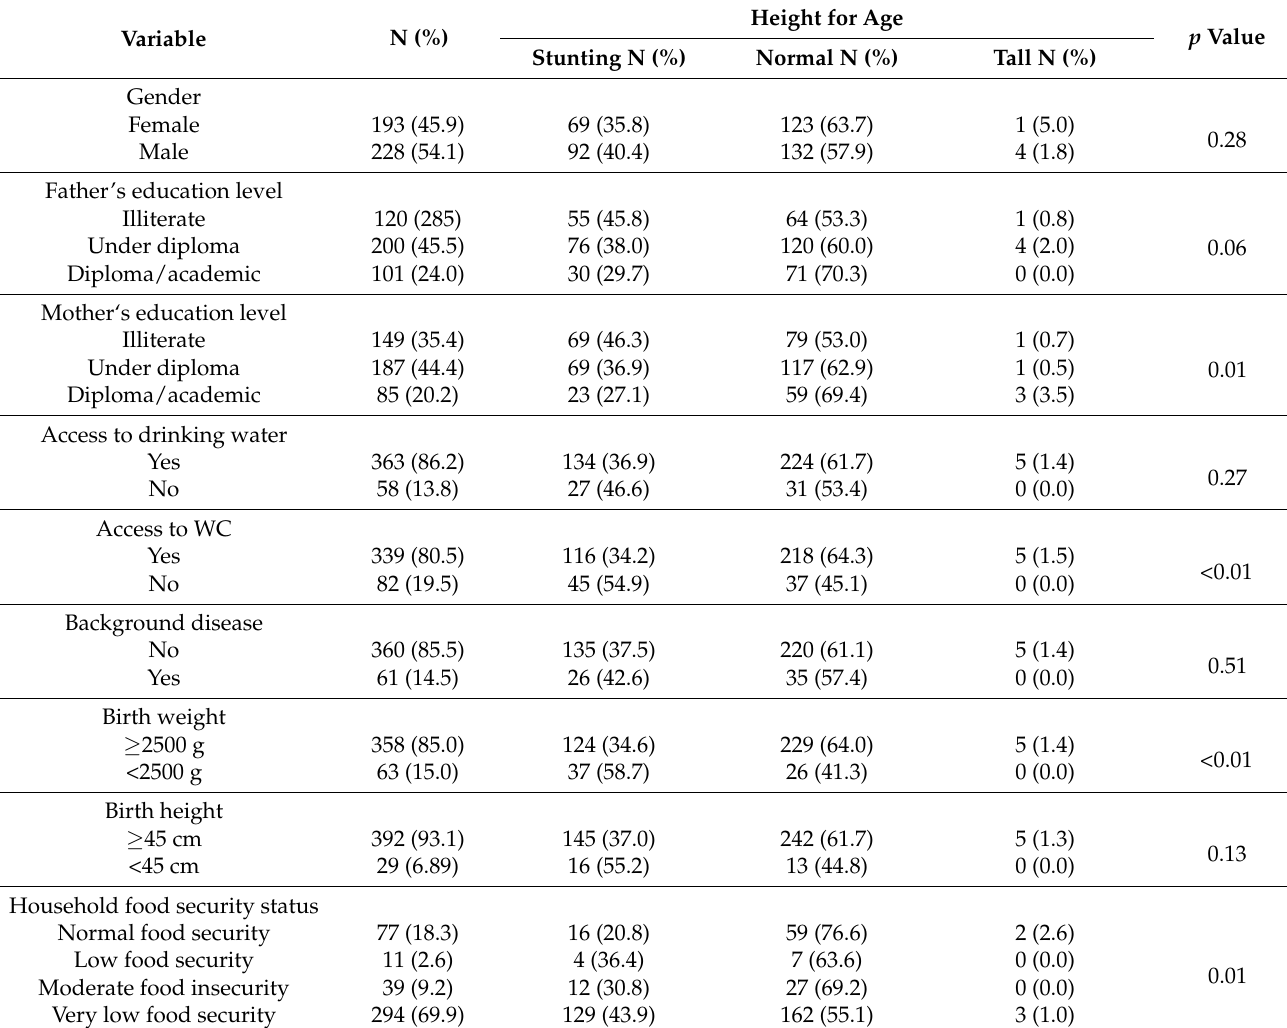
Table 2. The participants’ sociodemographic characteristics by height for